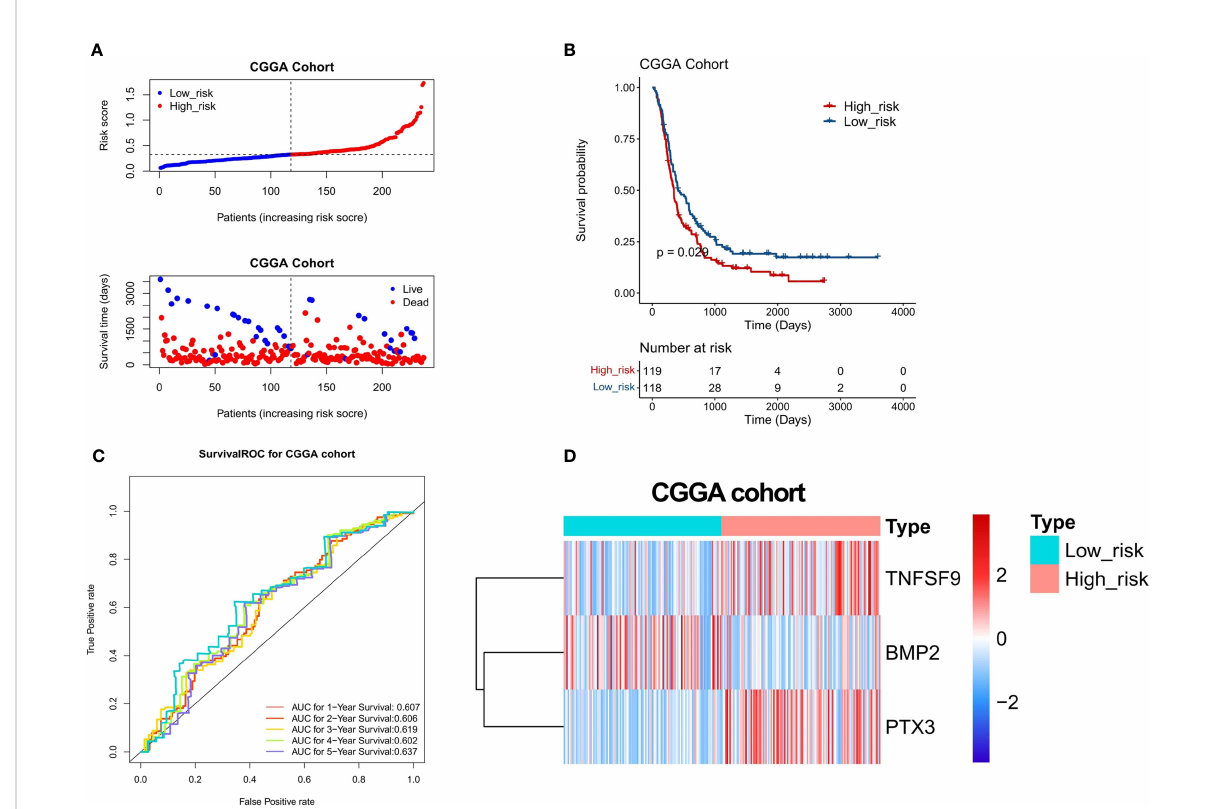
FIGURE 7 Validation of a 3-gene-based prognostic model using the CGGA validation set (n = 248). (A) The prognostic curve and a scatter plot for the validation set. (B) The Kaplan – Meier OS curves of the high- and low-risk groups for the validation set ( P = 0.029). (C) ROC curve for the validation set (AUC >0.6). (D) The heat map of the gene expression pro fi les of the three model genes in the validation